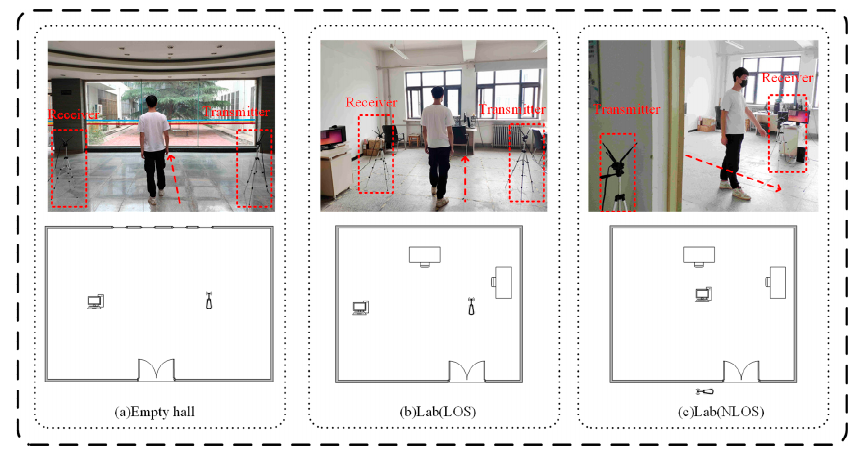
Figure 5. Laboratory and open hall experimental environment. ( a ) Empty hall, ( b ) Lab (LOS), ( c ) Lab (NLOS). LOS, line of sight; NLOS, none line of sight.